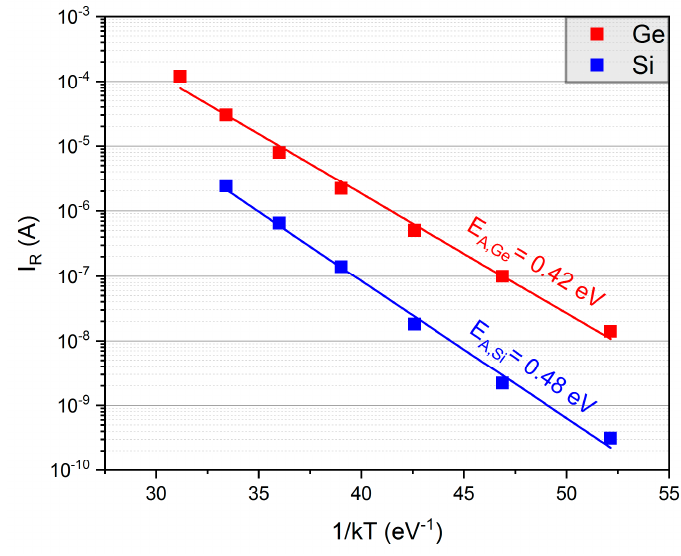
Figure 7. Arrhenius plot of the leakage current I R versus 1 / kT for 10 4 µ m 2 diodes where the bulk leakage dominates.